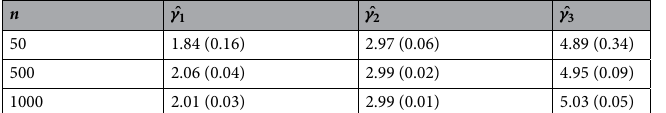
β j , β j and √ n (γ l ˆ (cid:31)